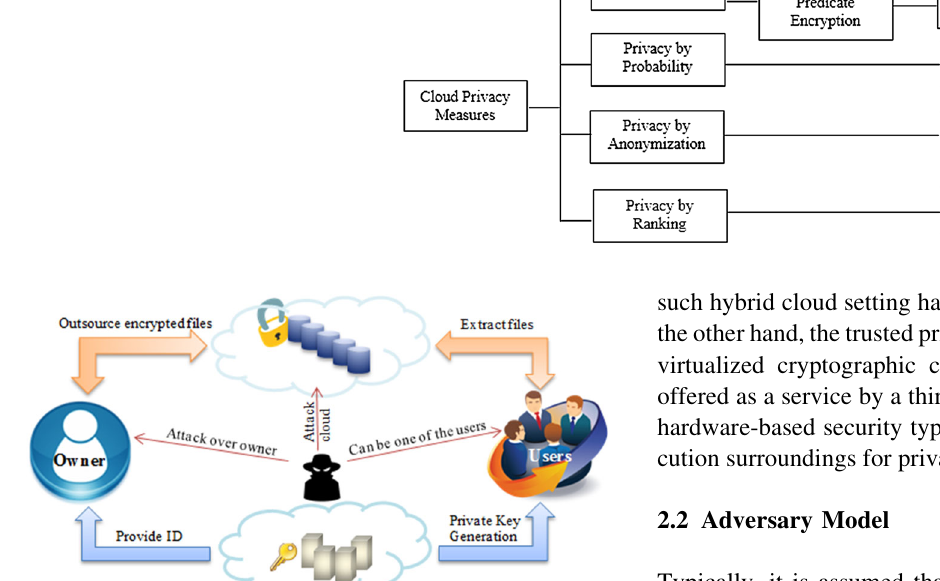
Fig. 2 Data privacy-preserving approaches